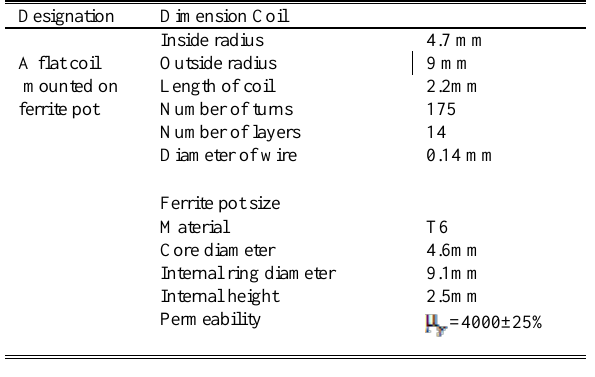
FIGURE 2. Giant magneto-resistor bridge sensor. [12] The sensing axis of the giant magnetoresistance (GMR) is coplanar with the inspected surface, the excitation field on the coil axis is perpendicular to the sensing axis of the giant magnetoresistance probe and perpendicular to the plate, Once the GMR is close to or on top of a defect, the eddy current flow path is altered, which changes the applied magnetic field due to variation of the mutual inductance between eddy currents and the excitation coil.